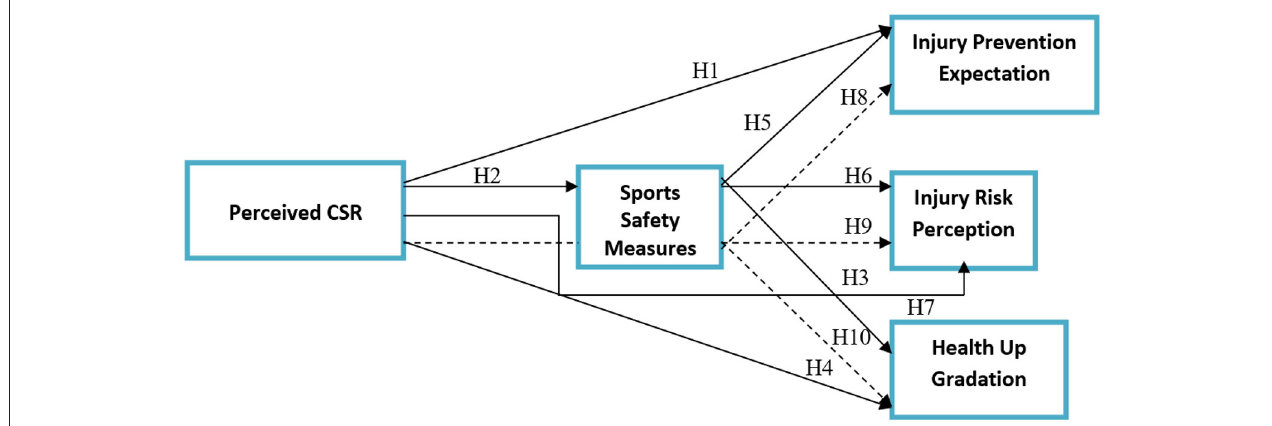
FIGURE 1 | Theoretical framework. PCSR, Perceived Corporate Social Responsibility; IPE, Injury Prevention Expectation; IRP, Injury Risk Perception; HU, Health Up Gradation; SSM, Sports Safety